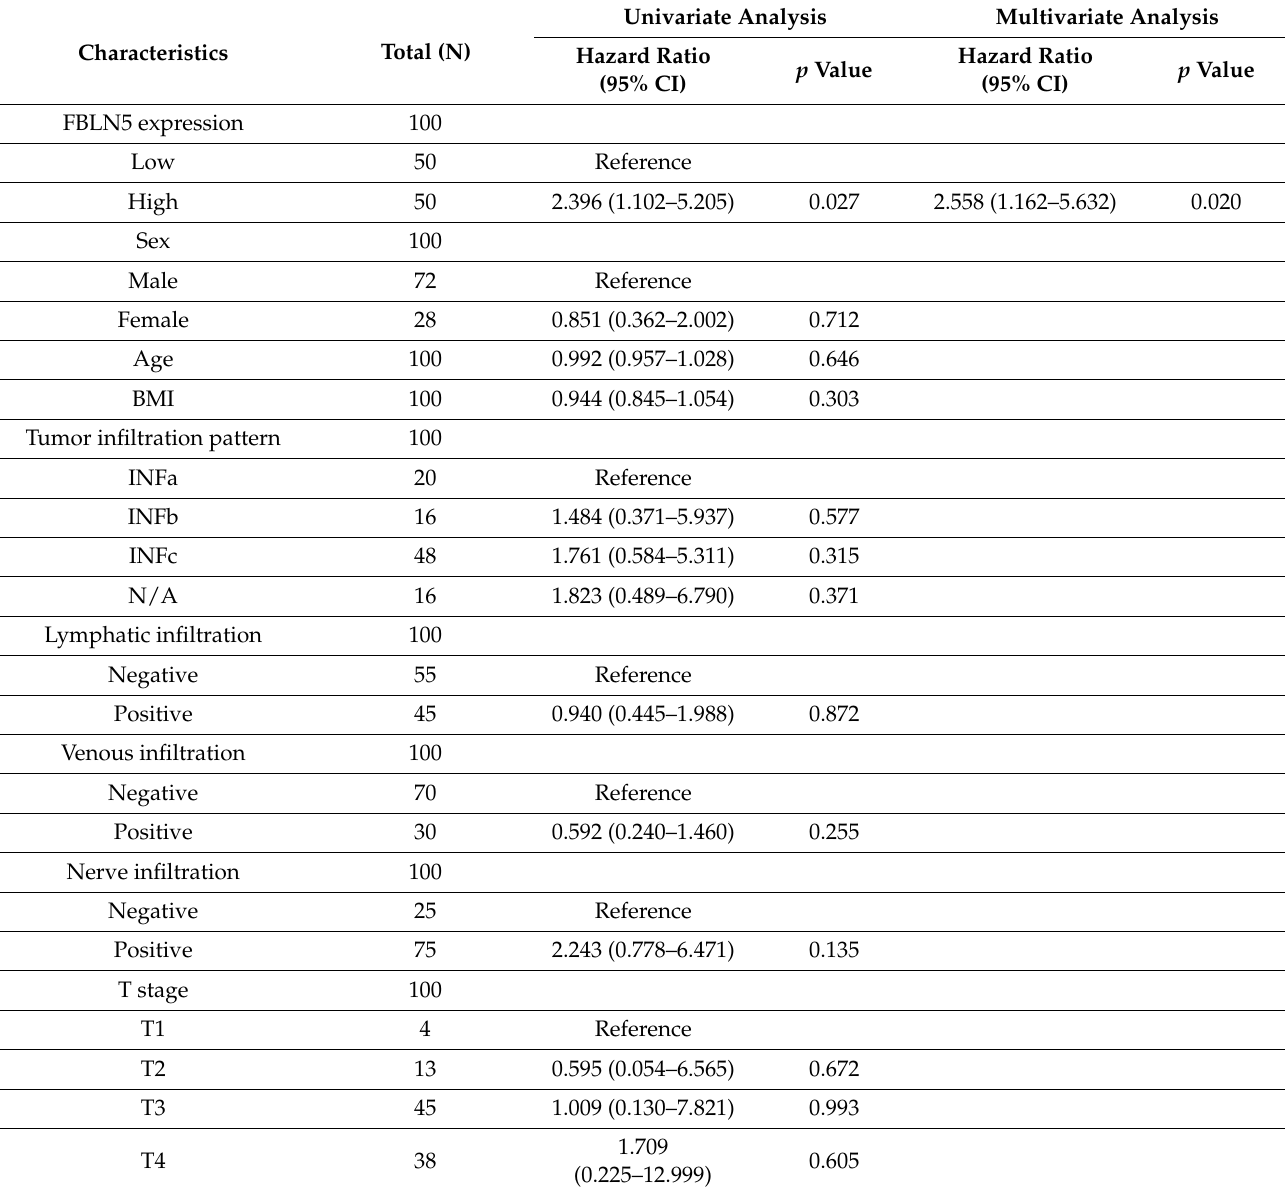
the cytoplasm and highly expressed in interstitial fibroblasts. ( A3 ) Another poorly differentiated adenocarcinoma. FBLN5 is highly expressed. ( A4 ) Mucinous adenocarcinoma. FBLN5 is highly expressed in the cytoplasm of mucinous adenocarcinoma and interstitial fibroblasts. ( B ) KM survival analysis curve of patients with different FBLN5 expression levels in a tissue micro-array. ( C ) FBLN5 expression levels in different cell lines ± s.d (no. of replicates = 3). ( D ) A nomograph prediction model based on the expression levels of FBLN5 and lymph node metastasis rate. ( E ) Survival curve based on the nomogram prediction model. ( F ) ROC curve predicted the feasibility of the nomograph prediction model. ( G ) Two-year and three-year calibration analysis. ( H ) DCA diagram based on the expression of FBLN5 and metastasis. * p < 0.05. Table 2. Cox univariate and multivariate analyses of FBLN5 gene